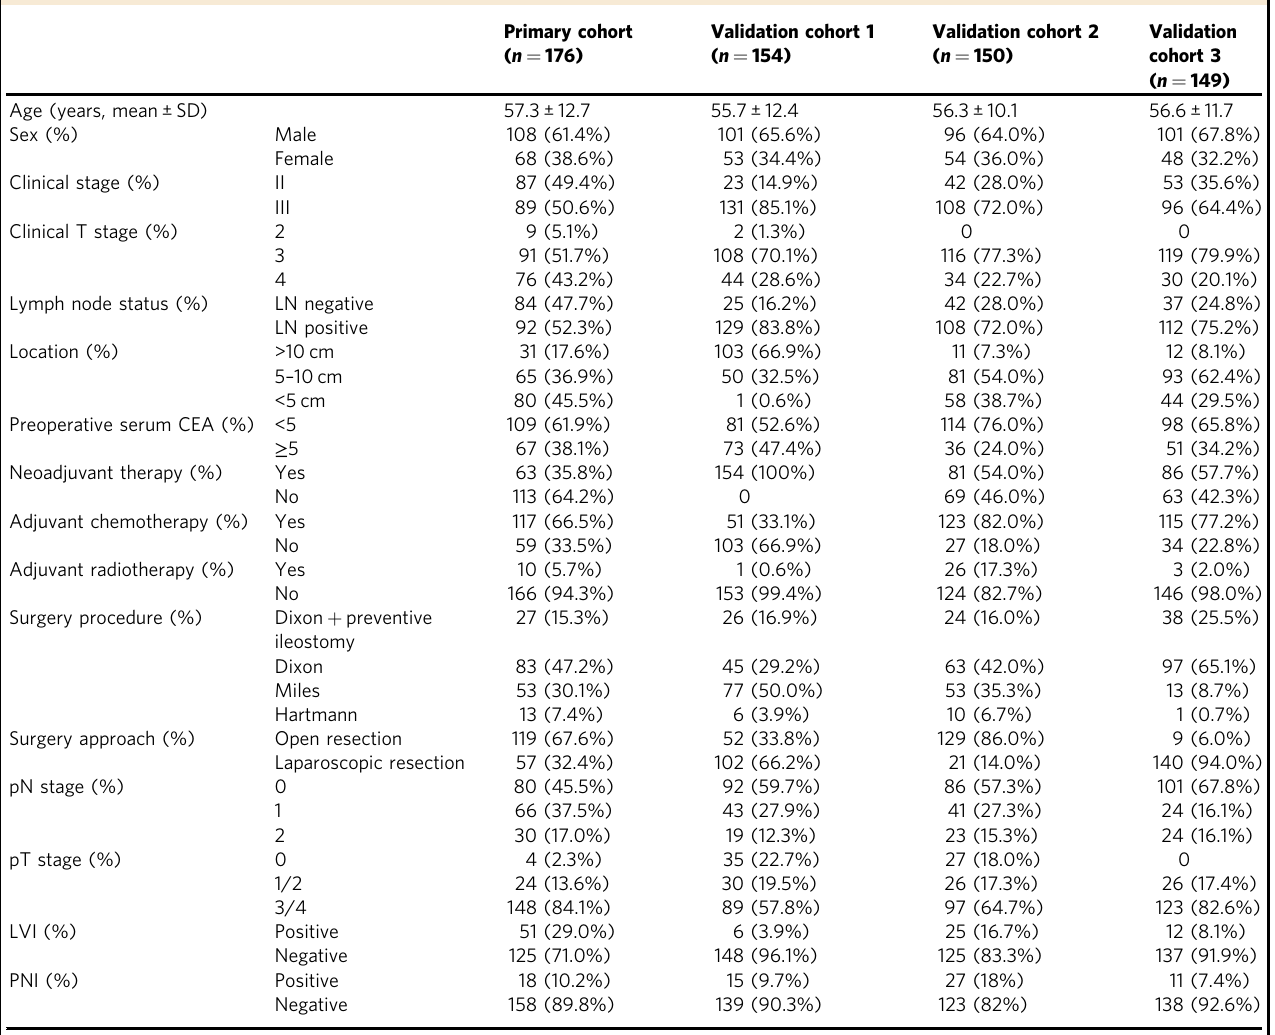
Table 1 Demographic and clinicopathological